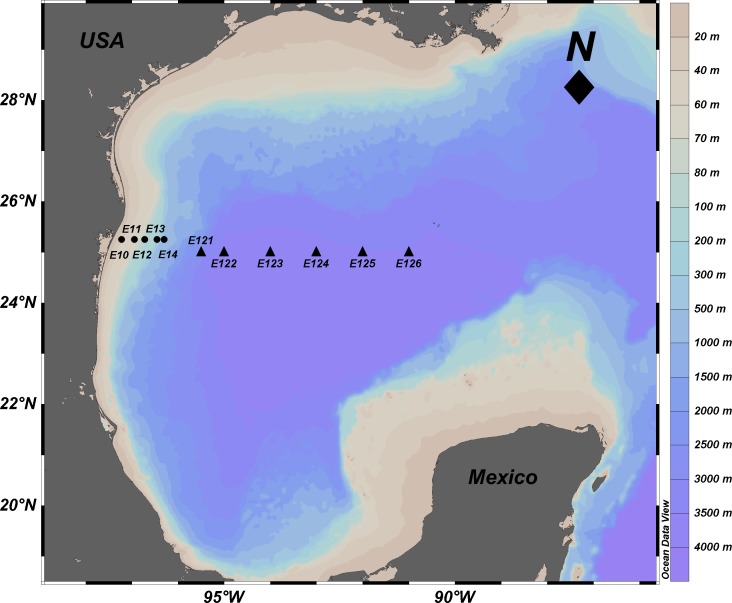
Location of sampling sites in the Mexican Region of the Northwestern Gulf of Mexico. Circles: shallow sites in the continental platform and slope from 20 to 600 m depth. Triangles: deep sites in the abyssal plain from 2,800 to 3,700 m depth. The names of the stations are indicated. Source credit: Abril Gamboa-Muñoz.